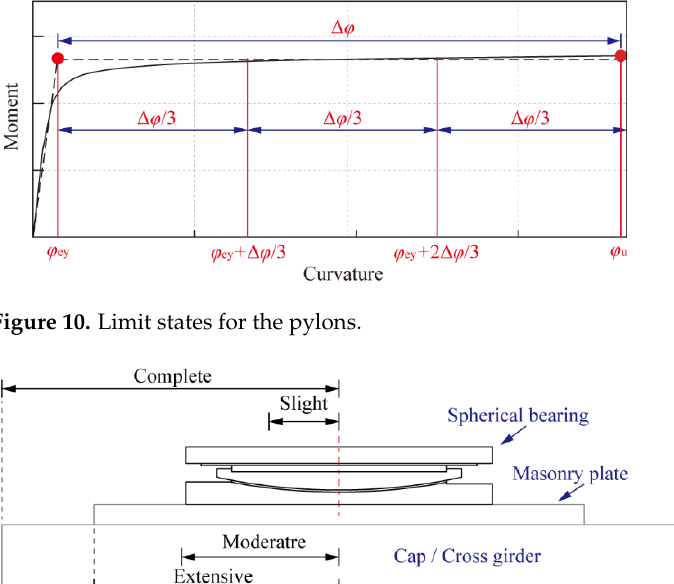
Table 8. Damage index for different damage states. EDP